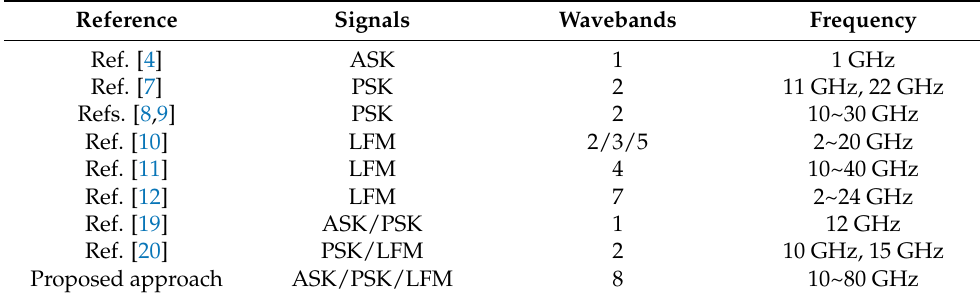
Table 1. Performance comparison of proposed approach with other published